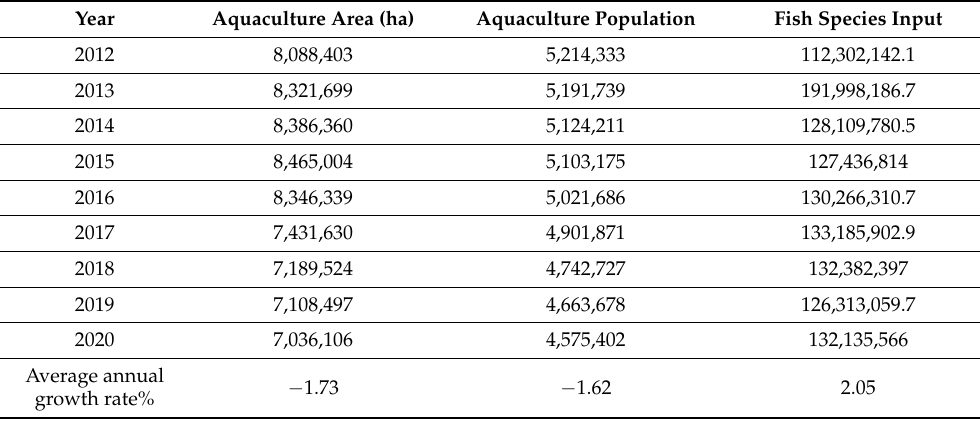
Table 1. Factor input data of aquaculture in China from 2012 to